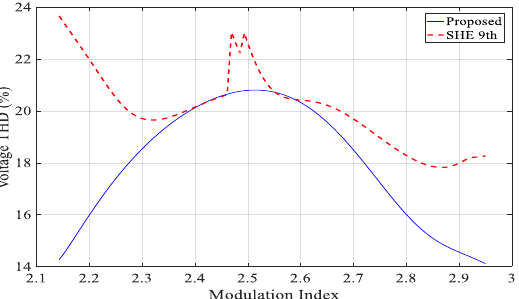
Figure 11. Curve showing variation between the Voltage THD in percent and modulation index for SHE of 9th order harmonics and for the proposed technique.